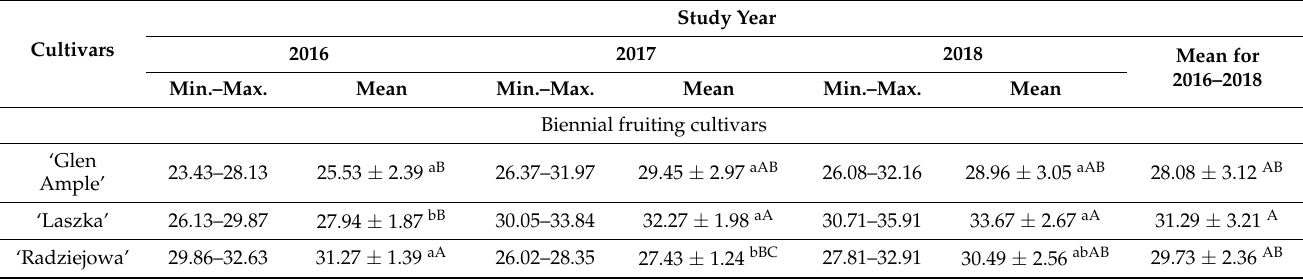
Table 3. Percent content of total protein in pollen from six R. idaeus